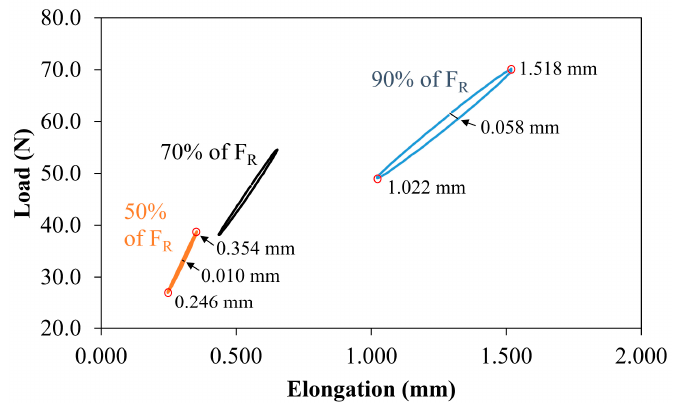
Figure 5. Typical hysteric cycles at the 100th cycles for the TiO 2 / UHMWPE samples (1 wt% of TiO 2 ) subjected to 90%, 70%, and 50% of F R .